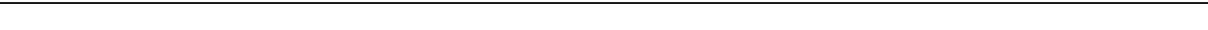
Fig. 2 Cyclin K is required for cell proliferation. a Knockdown of cyclin K by two short-hairpin RNA constructs (shRNA, K1, K2) in HCT116 cells. sc, scrambled shRNA. Left panel, protein blot analysis. Right panel, qPCR analysis. Data are means ± SEM ( n = 7) (*** p < 0.001; Student ’ s t -test). b Time course analyses of cell number after cyclin K knockdown in HCT116 cells. Right panel, bright- fi eld microscopy of cells at day 6. Scale bar, 200 μ m. Data are means ± SEM ( n = 5) (*** p < 0.001; Student ’ s t -test). c Similar experiments as in b using H1299 and HeLa cells. Data are means ± SEM ( n = 5) (*** p < 0.001; Student ’ s t -test). d The percentage of Annexin V-positive cells (marker of early apoptosis) was similar with or without cyclin K knockdown in HCT116 cells. e The percentage of sub-G1 fraction (apoptotic cells) was similar with or without cyclin K knockdown in HCT116 cells. f Cell cycle pro fi ling by fl uorescence-activated cell sorting (FACS) analyses with or without cyclin K knockdown in HCT116 cells for up to 5 days. g Cell cycle pro fi ling of HCT116 cells treated with or without cyclin K knockdown for 2.5 days, followed by 14-h nocodazole treatment (800 ng/ml). h Detection of EdU-positive HCT116 cells (proliferating cells) by FACS with or without cyclin K knockdown for 3 days. Quantitation was generated from fi ve independent experiments. Data